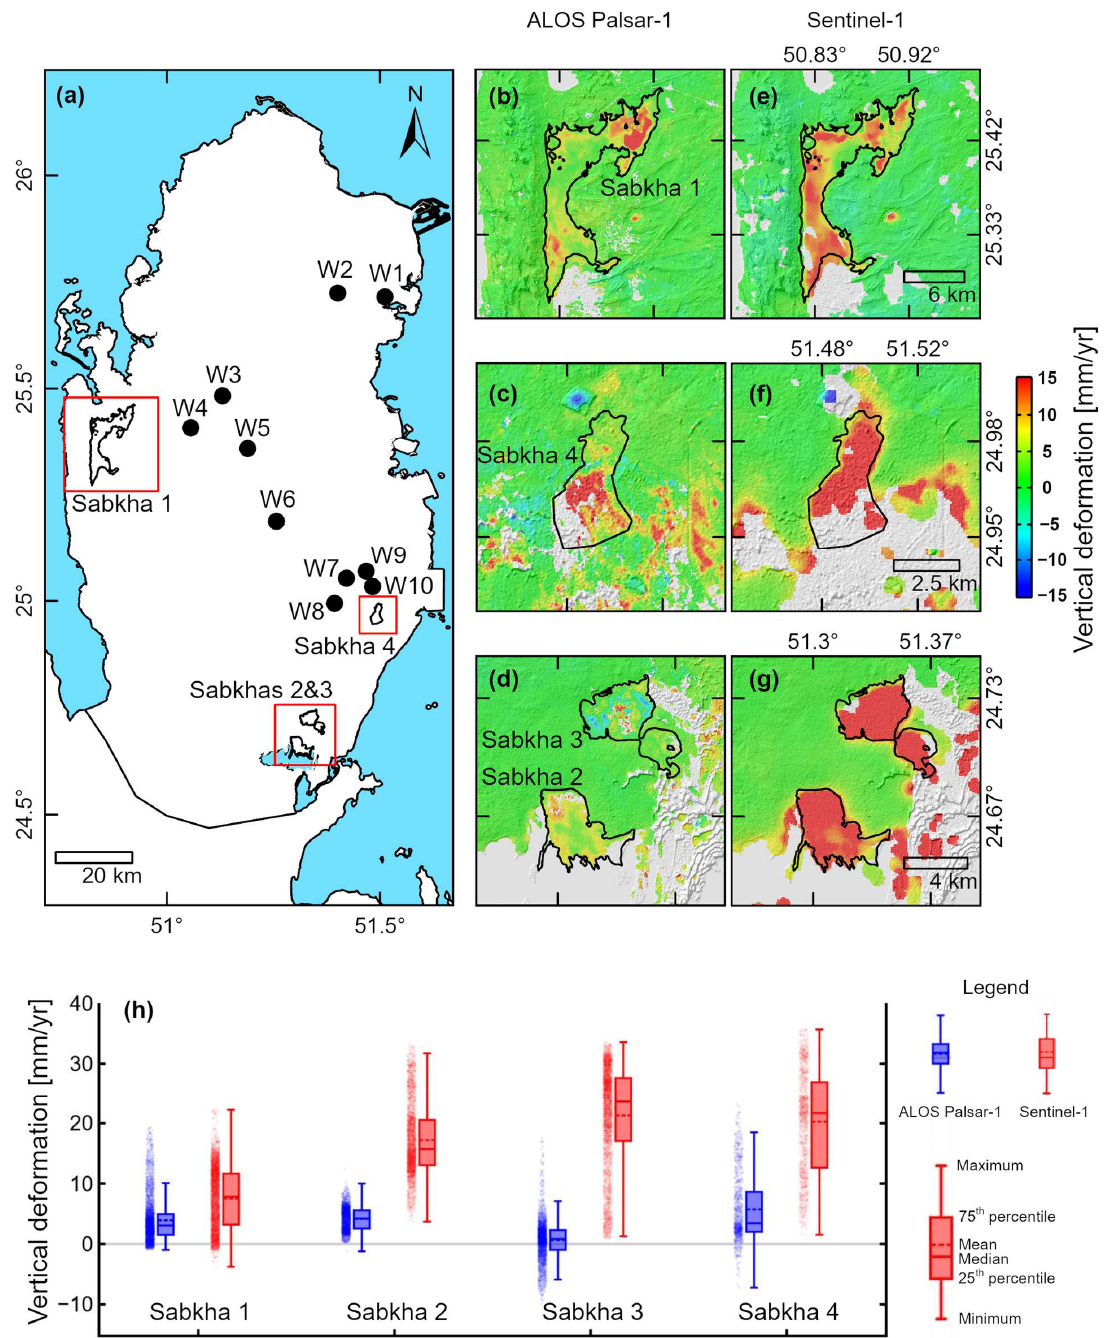
Figure 4. Distribution and deformation rates of the investigated inland and coastal sabkhas. ( a ) Locations of the investigated sabkhas and proximal monitoring wells (W1–W10). ( b – d ) Deformation rate maps over the investigated sabkhas during the ALOS Palsar-1 period (December 2007–December 2010) for areas outlined by red box in Figure 4a. ( e – g ) Deformation rate maps during the Sentinel-1 period (March 2017–June 2019) for areas outlined by red box in Figure 4a. ( h ) Boxplot for the deformation rates within the sabkha boundaries during the ALOS Palsar-1 and Sentinel-1 periods. The boundaries of the sabkhas were modified from the geological map of Qatar [35]. Time series of cumulative deformation averaged over each sabkha is given in Figure 5. Abbreviations are defined in caption of Figure 1 c .